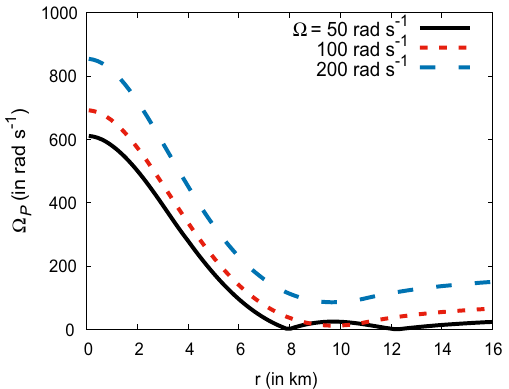
Fig. 12 Overall precession frequency along the equator for a 1 . 5 M 0 NS ( ω = 700 rad s − 1 ) with a sense of orbital angular velocity of the gyro opposite to that of star’s rotation. The black solid curve is for Ω = 50 rad s − 1 , the red short dashed curve is for Ω = 100 rad s − 1 , and the blue dashed curve is for Ω = 200 rad s − 1